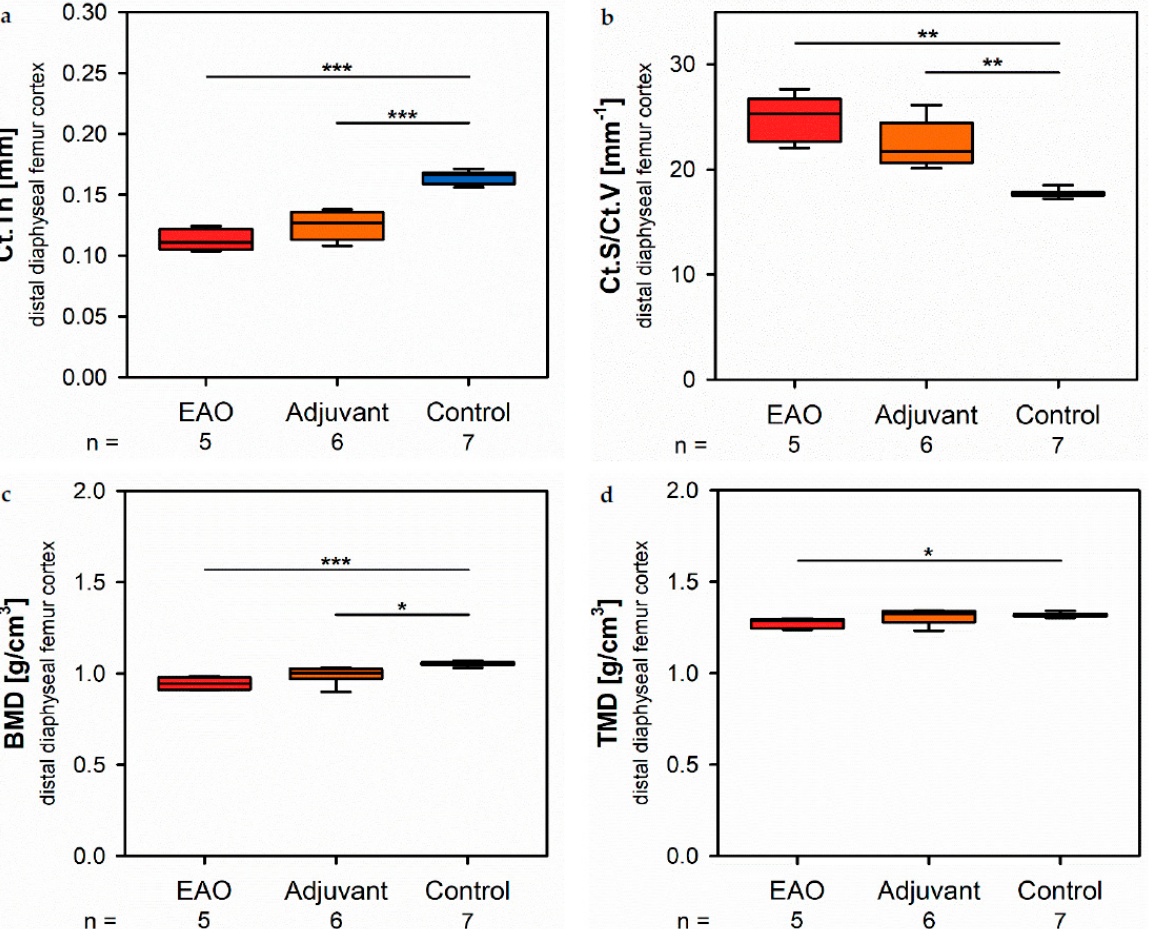
Figure 5. Microarchitecture of distal diaphyseal femur cortex in µCT. Measurement of ( a ) cortical thickness (Ct.Th), ( b ) cortical surface/volume ratio (Ct.S/Ct.V), ( c ) bone mineral density (BMD) and ( d ) tissue mineral density (TMD). Mice were immunized with testicular homogenate in adjuvant (EAO), adjuvant alone (adjuvant) or remained untreated (control). * p < 0.05; ** p < 0.01; *** p < 0.001.